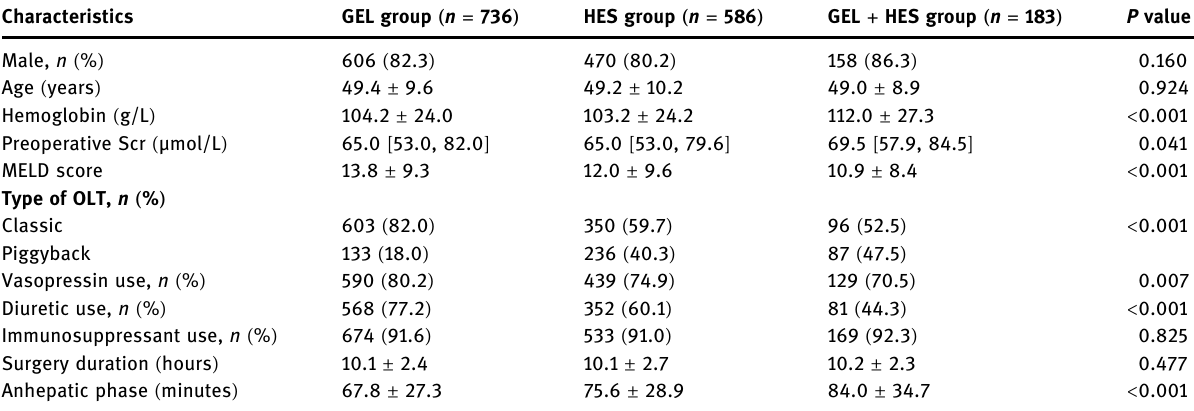
Table 1: Clinical characteristics of enrolled subjects